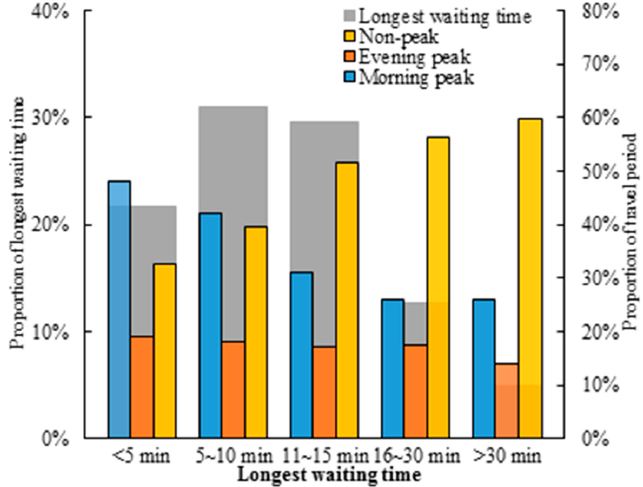
Figure 3. Passengers’ endurance of delay time in different period. Table 2. Estimation results of route choice models.